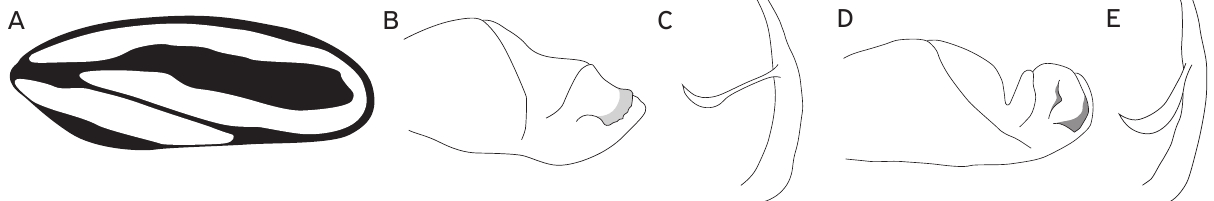
Figura 1. Mahanarva spectabilis. A: tégmina direita; B: parâmero esquerdo; C: edeago; Mahanarva liturata. D: parâmero esquerdo; E: